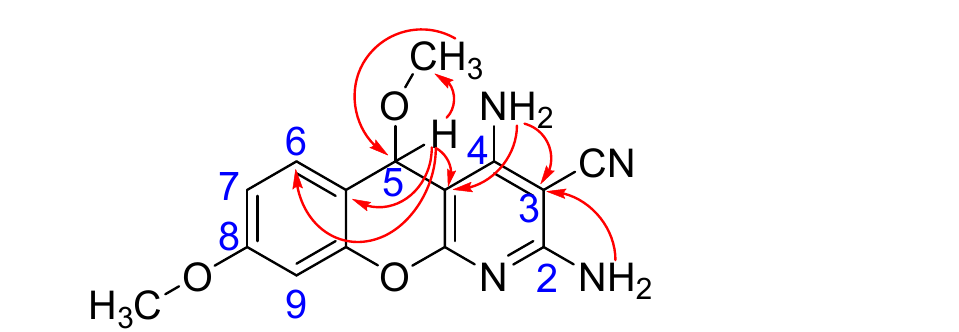
Figure 3. The structure of chromeno[2,3- b ]pyridine 4d . Key 1 H- 13 C-HMBC NMR correlations are shown by arrows.